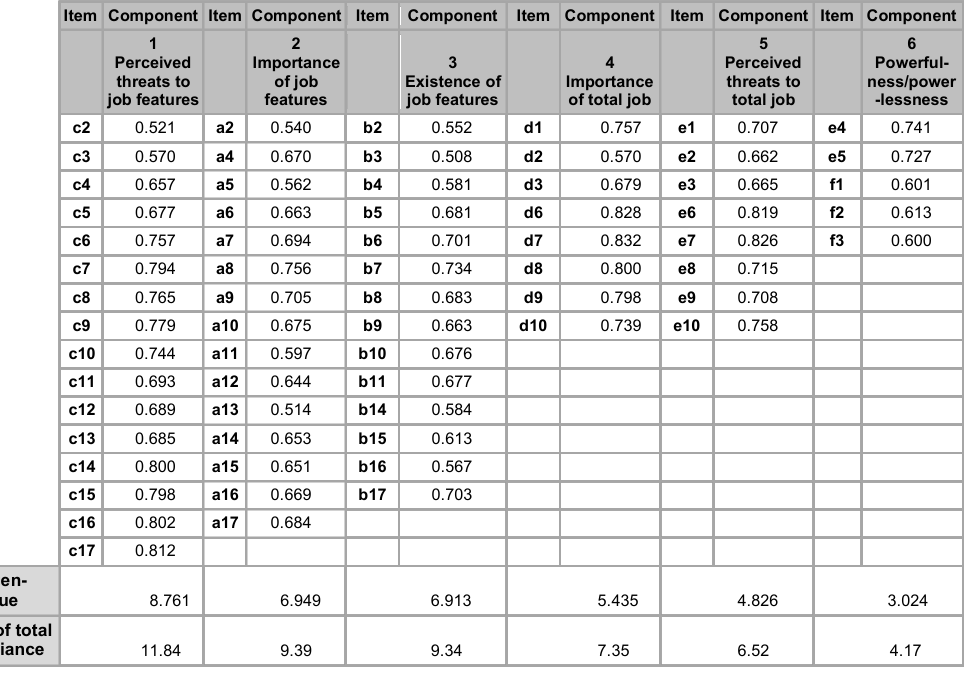
Factor analysis: dimensions of job insecurity